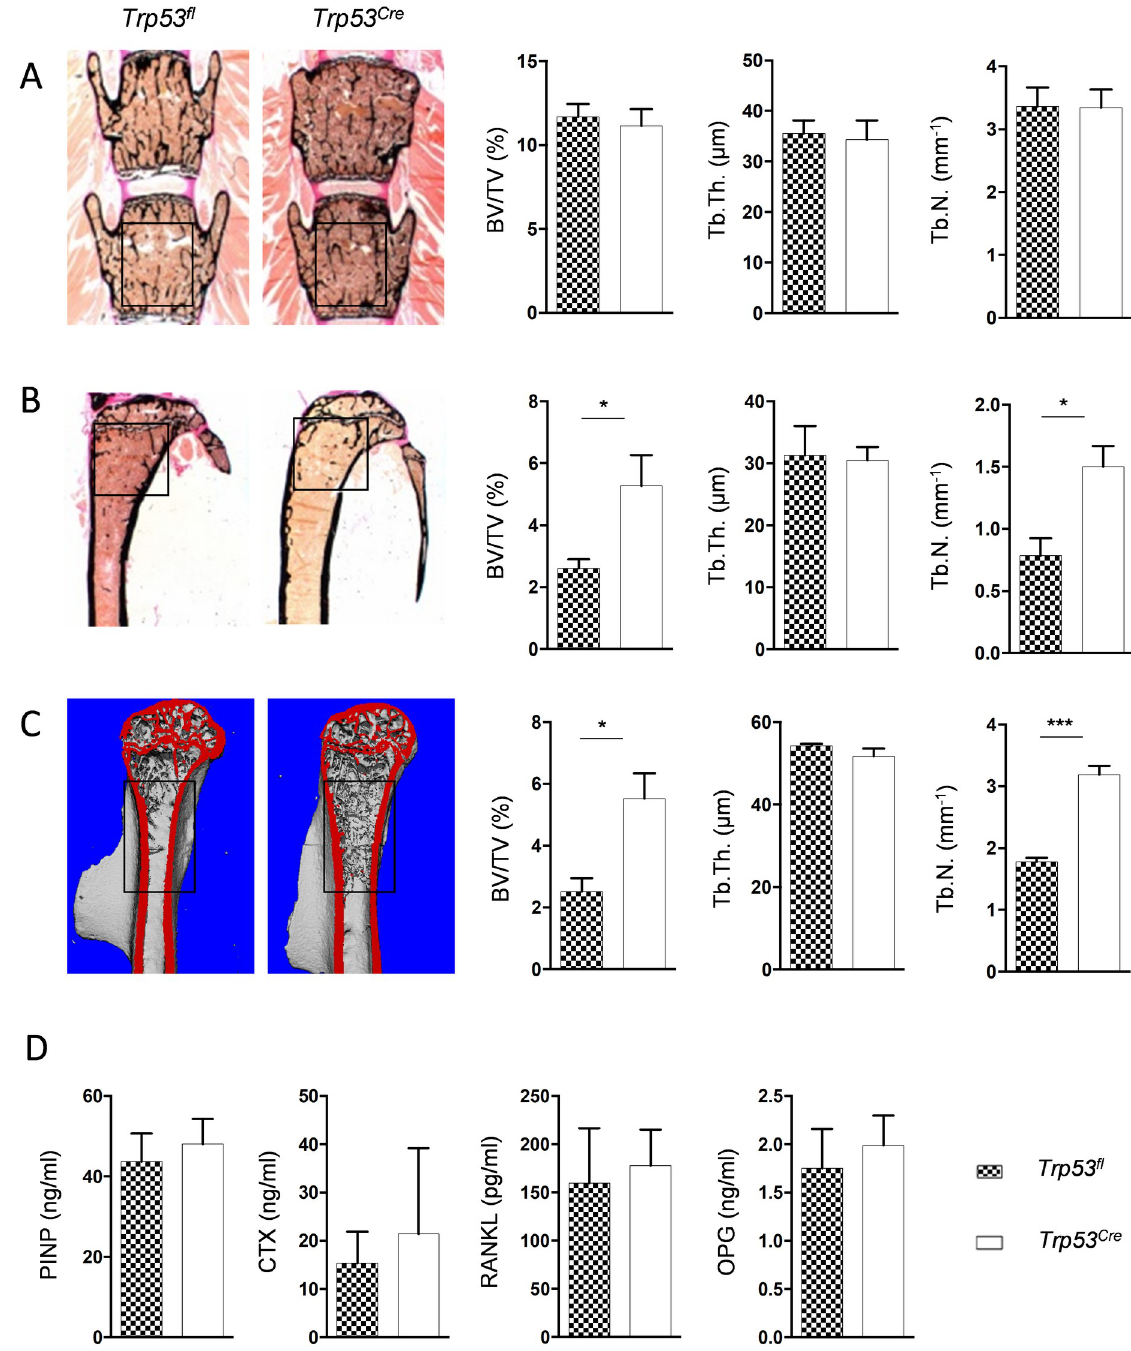
Fig 4. The Trp53 Cre bone phenotype is site-specific. (A) Representative images of undecalcified spine sections from from 6-month-old male mice with the indicated genotypes. Quantification of BV/TV, Tb.Th. and Tb.N., measured in the indicated region, is shown on the right. (B) Representative images of undecalcified tibia sections from the same mice. Quantification of BV/TV, Tb.Th. and Tb.N., measured in the indicated region, is shown on the right. (C) Representative μ CT images of humeri from the same mice. Quantification of BV/TV, Tb.Th. and Tb.N., measured in the indicated region, in shown on the right. (D) Serum concentrations of PINP, CTX, RANKL and OPG in the same groups of mice. Data represent mean ± SD (n � 6). Asterisks indicate statistically significant differences ( � p < 0.05, ��� p < 0.0005).